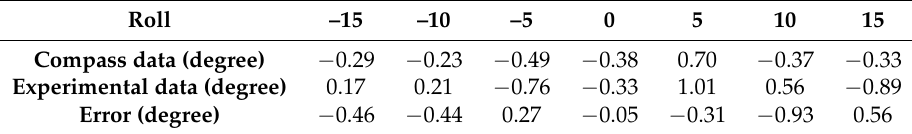
Figure 6. Yaw angle comparison with pitch and roll angles at − 30 ◦ and 0 ◦ . Table 3. Comparison of yaw angles with roll angles changed from − 15 ◦ to 15 ◦ .